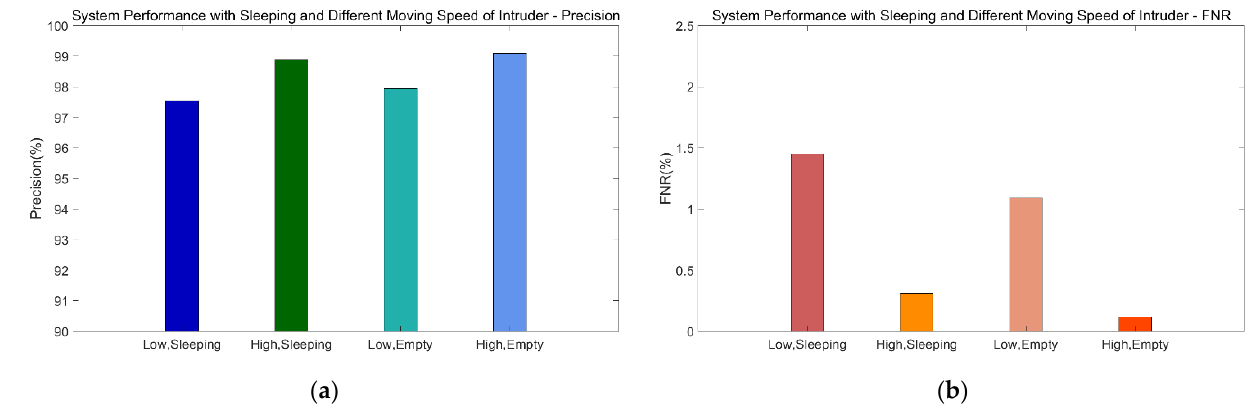
Figure 21. System performance in sleeping scenario. ( a ) Precision. ( b ) FNR.